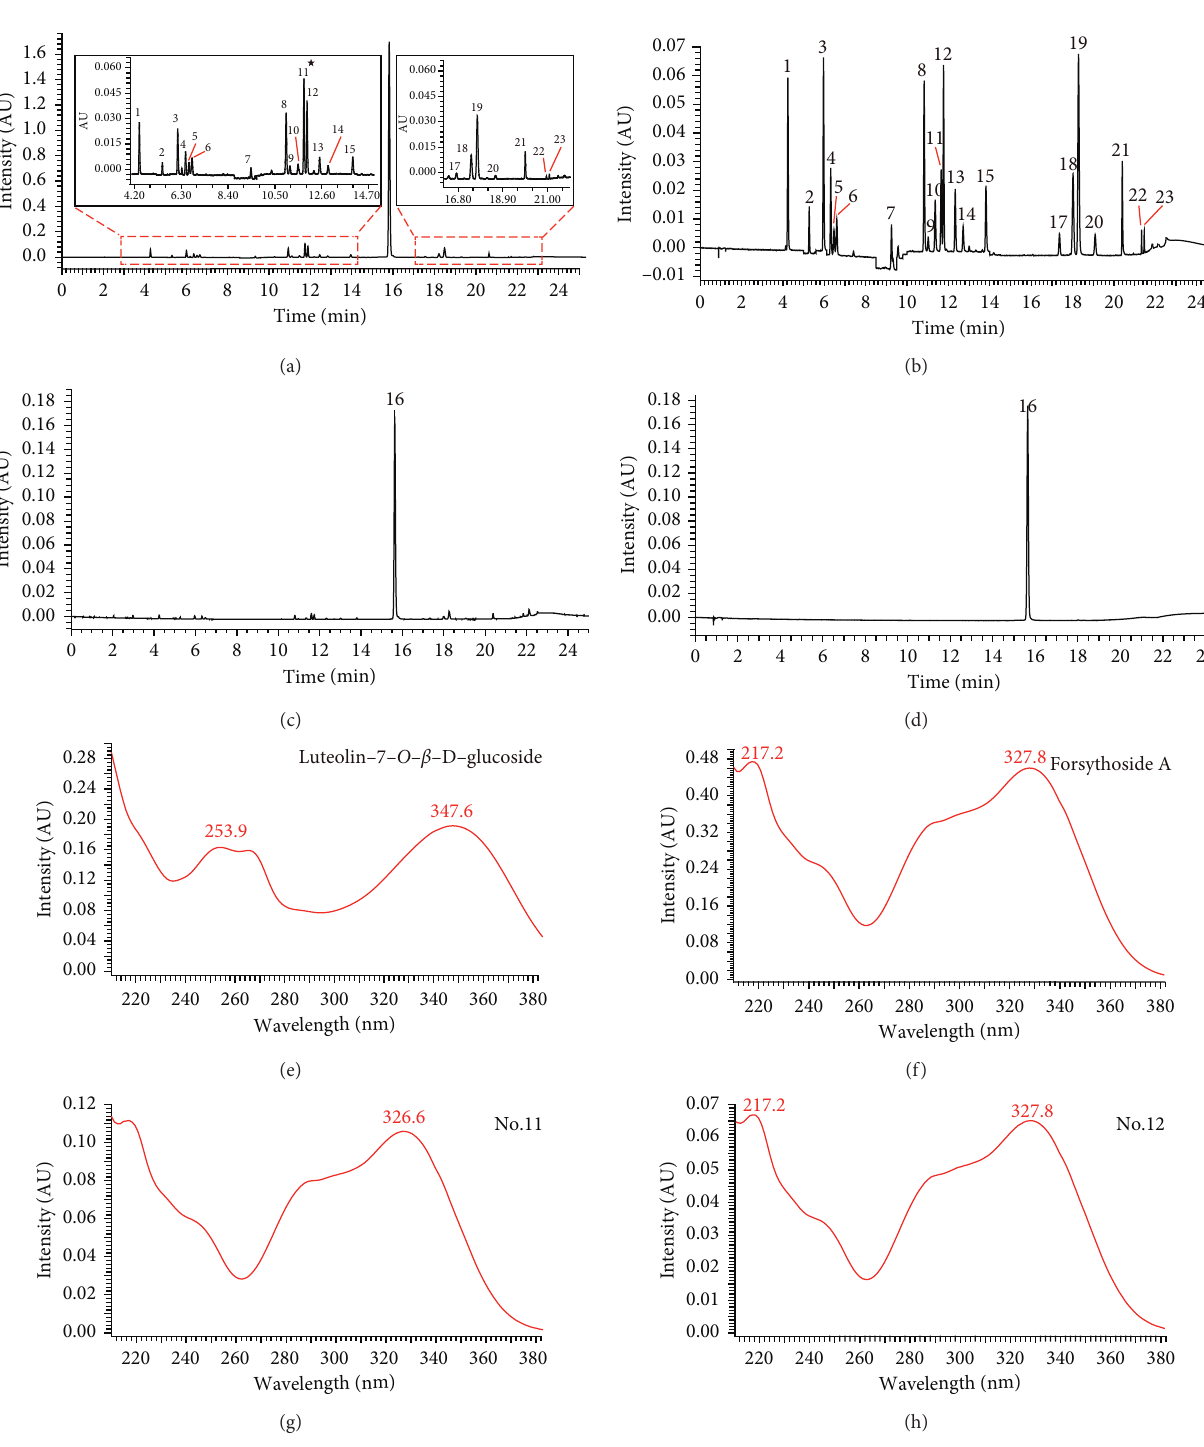
Figure 2: UPLC-PDA chromatograms of SHLI sample solution with low dilution ratio (a), the mixed standard solution (b), the SHLI sample solution with high dilution ratio (c) and the baicalin standard solution (d), the ultraviolet absorption curve of luteolin-7- O - β -D-glucoside (e), forsythoside A (f), no. 11 chromatographic peak (g), and no. 12 chromatographic peak